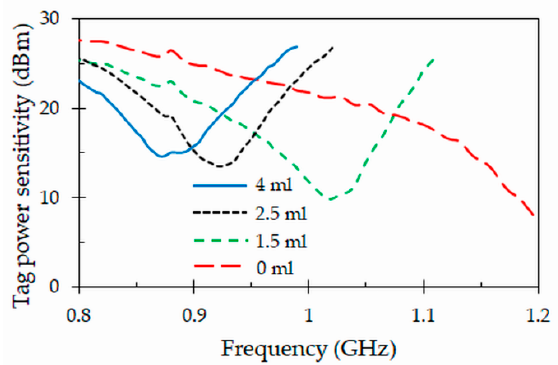
Figure 15. Tag power sensitivity obtained for the proposed tag (IC chip: NXP UCODE G2XL) attached to a clinic tube with different blood volumes.